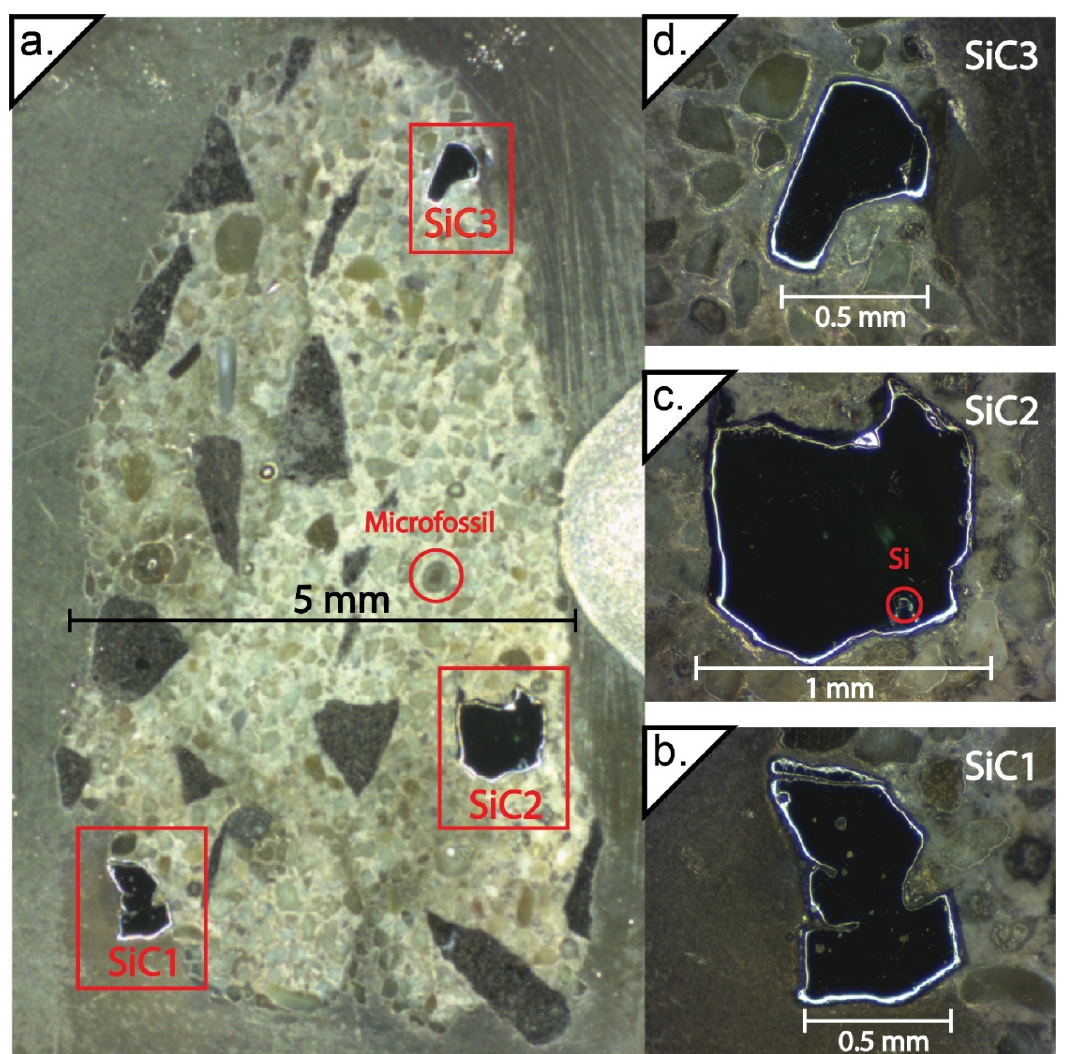
Figure 2. ( a ) The microscope image of the sample clearly shows the location of the SiC grains ( b – d ), which have different reflectivities from the surrounding rock matrix. The red circle indicates the location of a microfossil (Figure S1). Locations of SiC grains in a. and the Si inclusion in SiC2 ( c) are